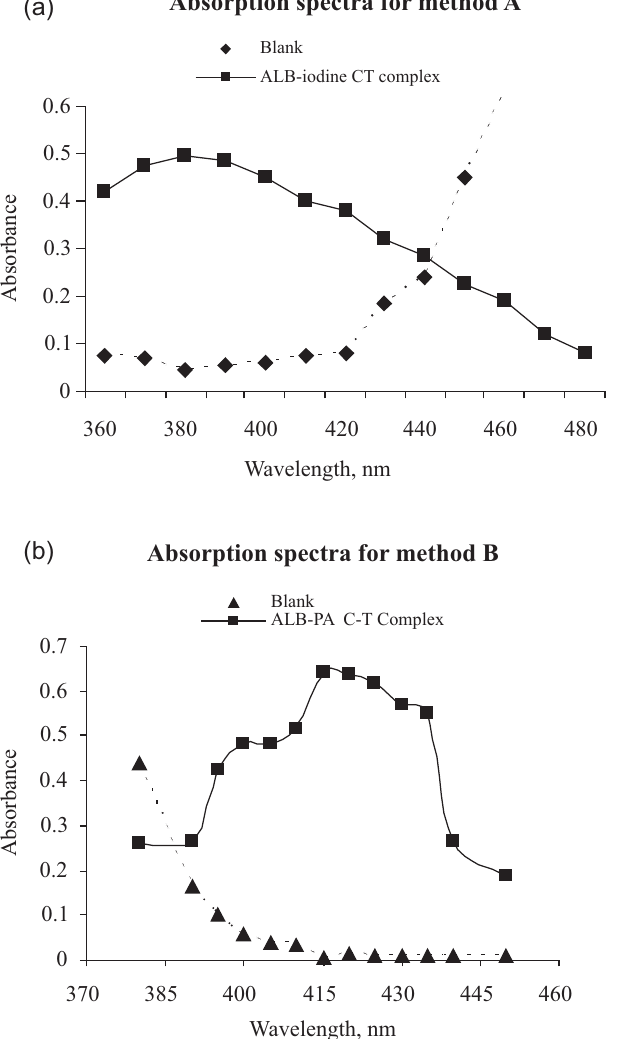
FIGURE 4 - (a) Absorption spectra of ALB-iodine CT complex ( ¢ ) [120 µg mL -1 ALB] against blank solution ( ¿ ); (b) Absorption spectra of ALB-PA CT complex ( ¢ ) [30 µg mL -1 ALB] against blank solution ( p ).